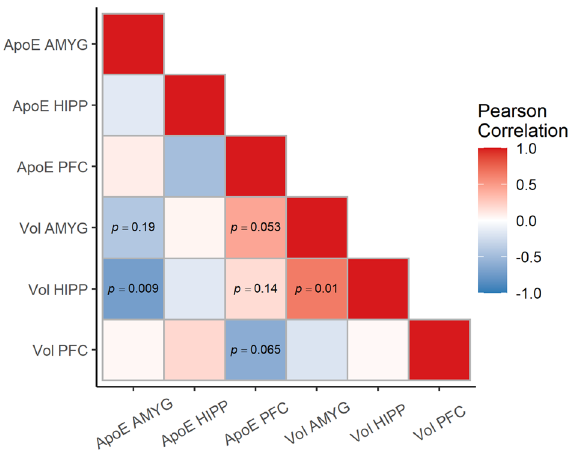
Figure 2. Correlation matrix of the regional apoE levels in the amygdala (AMYG), hippocampus (HIPP), and prefrontal cortex (PFC) and the relative volumes of those regions. Correlations meeting a p < 0.20 threshold are shown in the correlation matrix and were used for subsequent analysis.